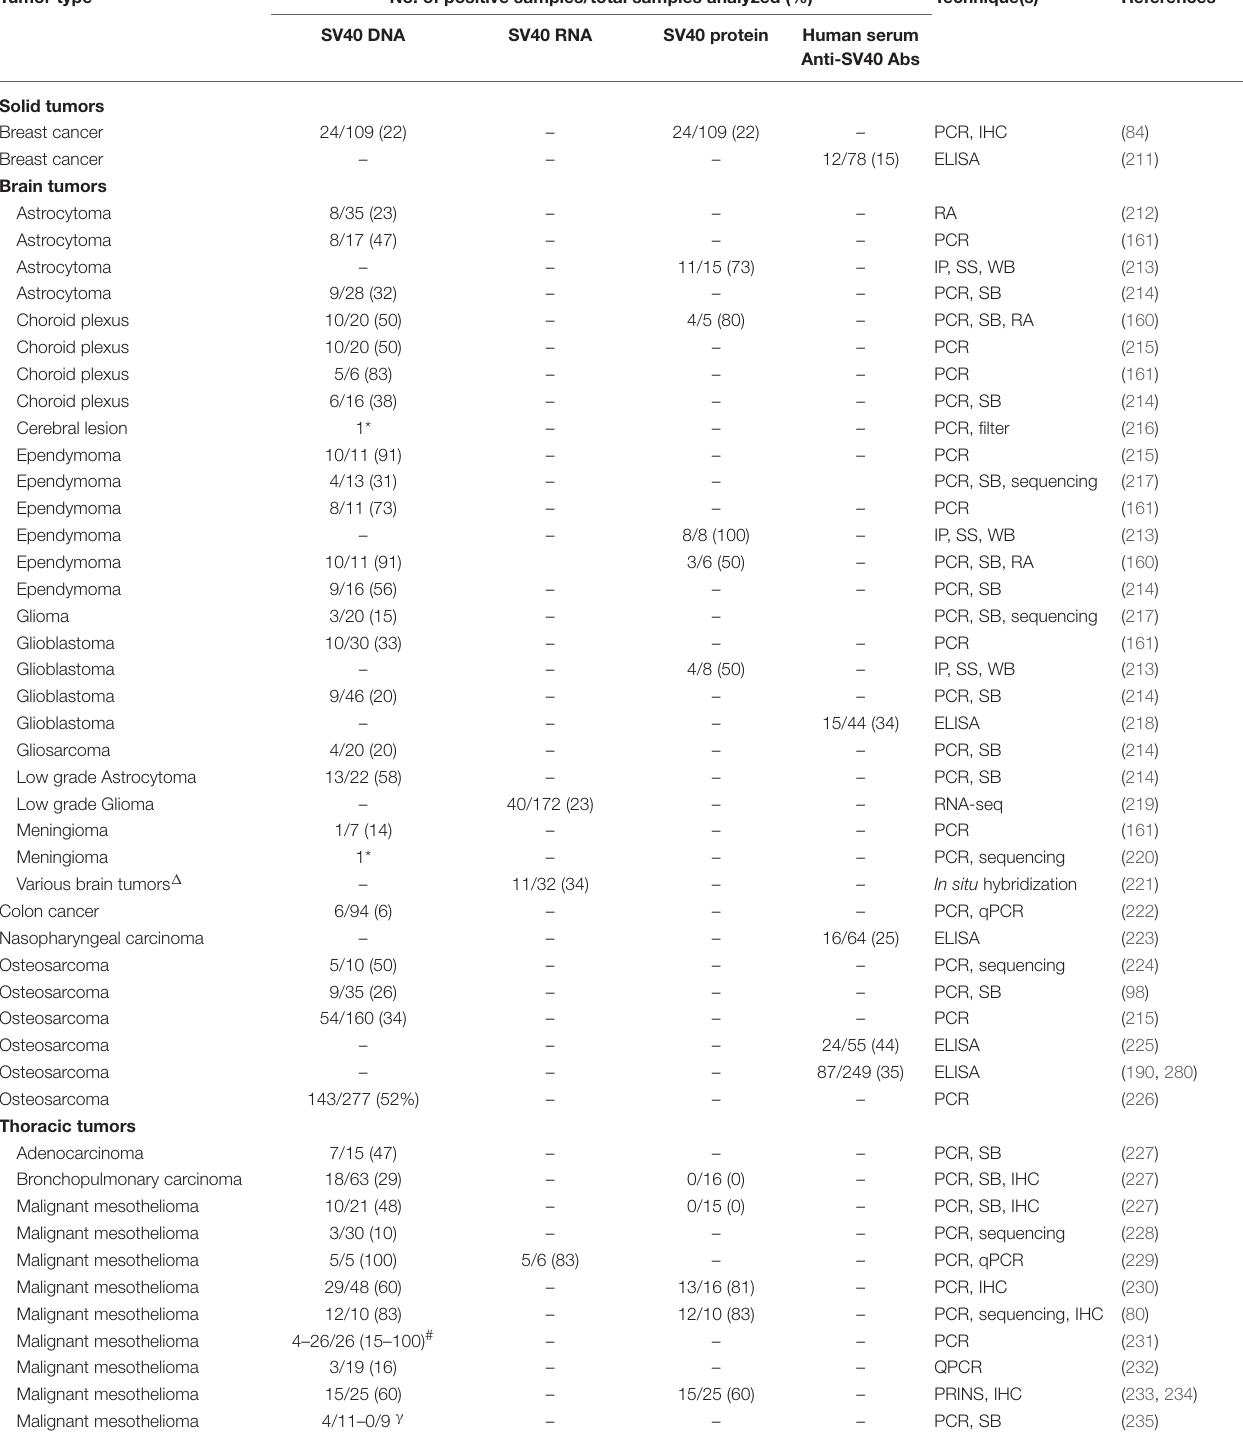
TABLE 2 | SV40-positive human